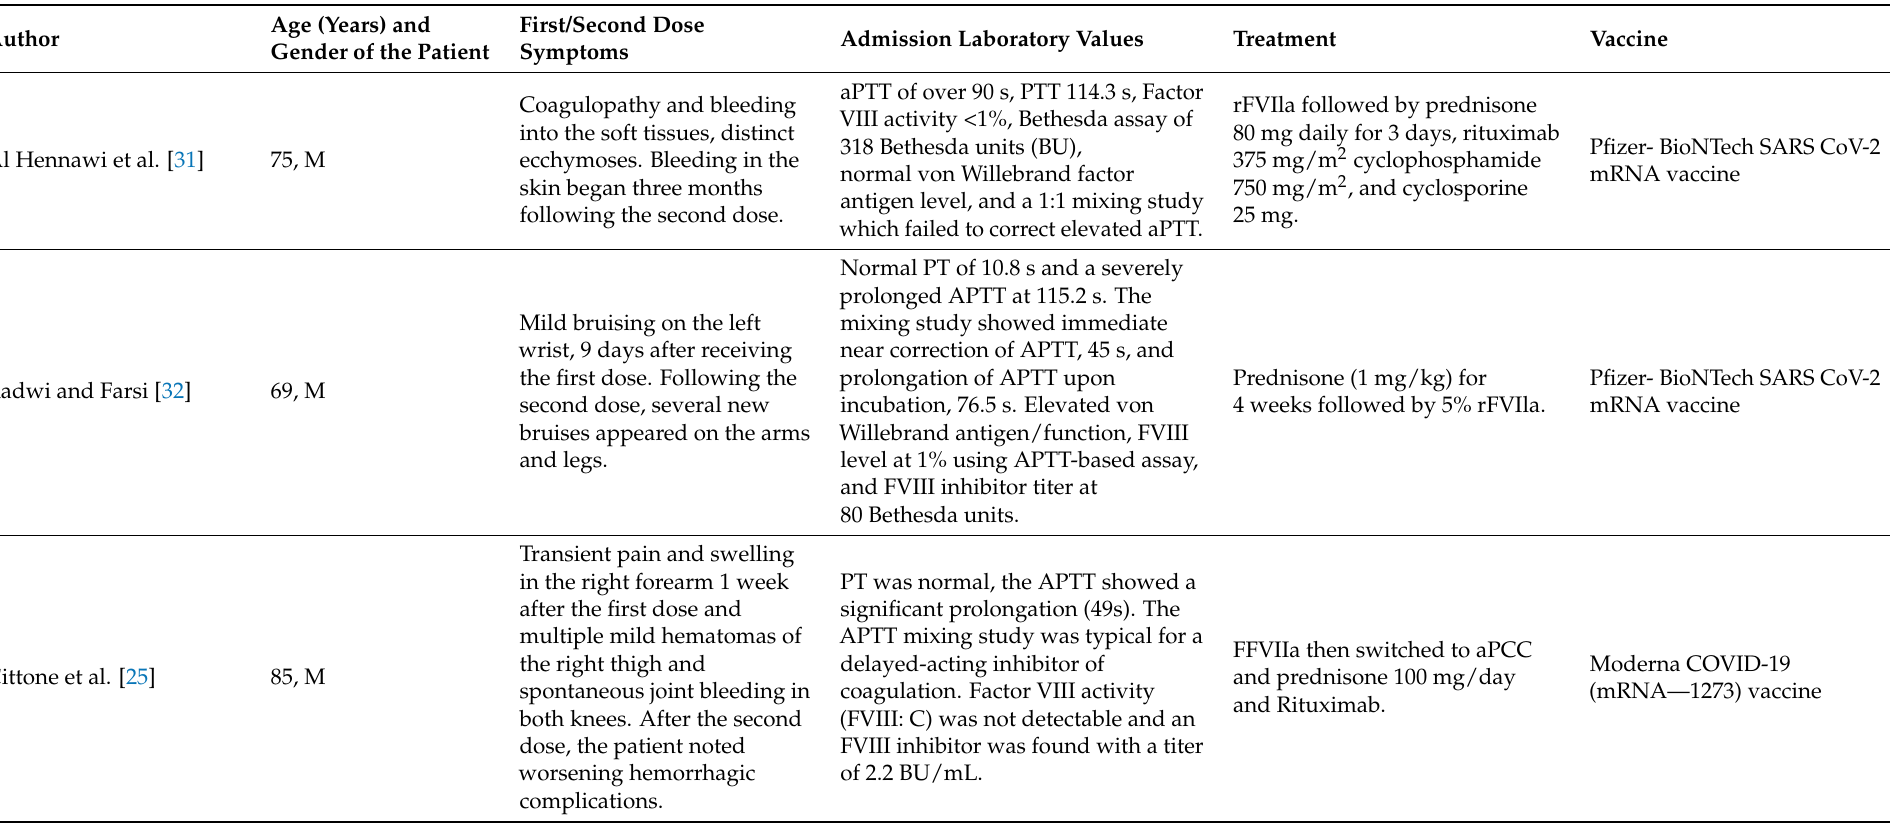
Table 1. Overview of cases of acquired hemophilia A attributed to COVID-19 vaccines. aPCC = activated prothrombin complex concentrate; FEIBA = Factor